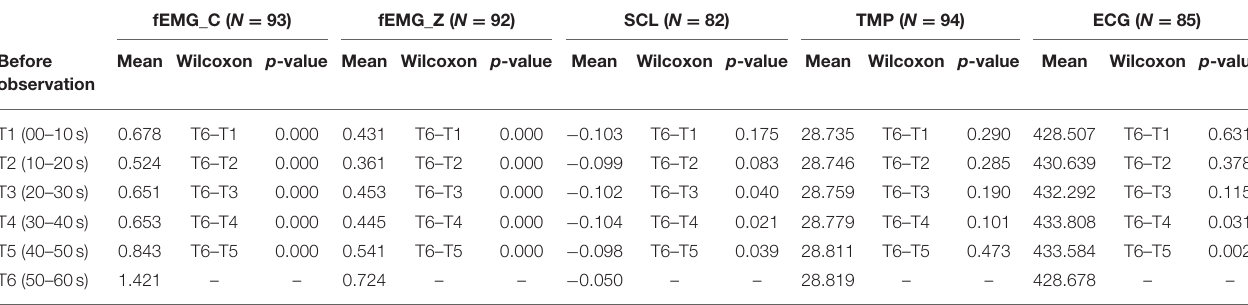
TABLE 2 | Autonomous sympathetic activity before movement observation ( n = 94) to six events T1-5 vs. T6. fEMG_C ( N = 93) fEMG_Z ( N = 92) SCL ( N = 82) TMP ( N = 94) ECG ( N = 85)